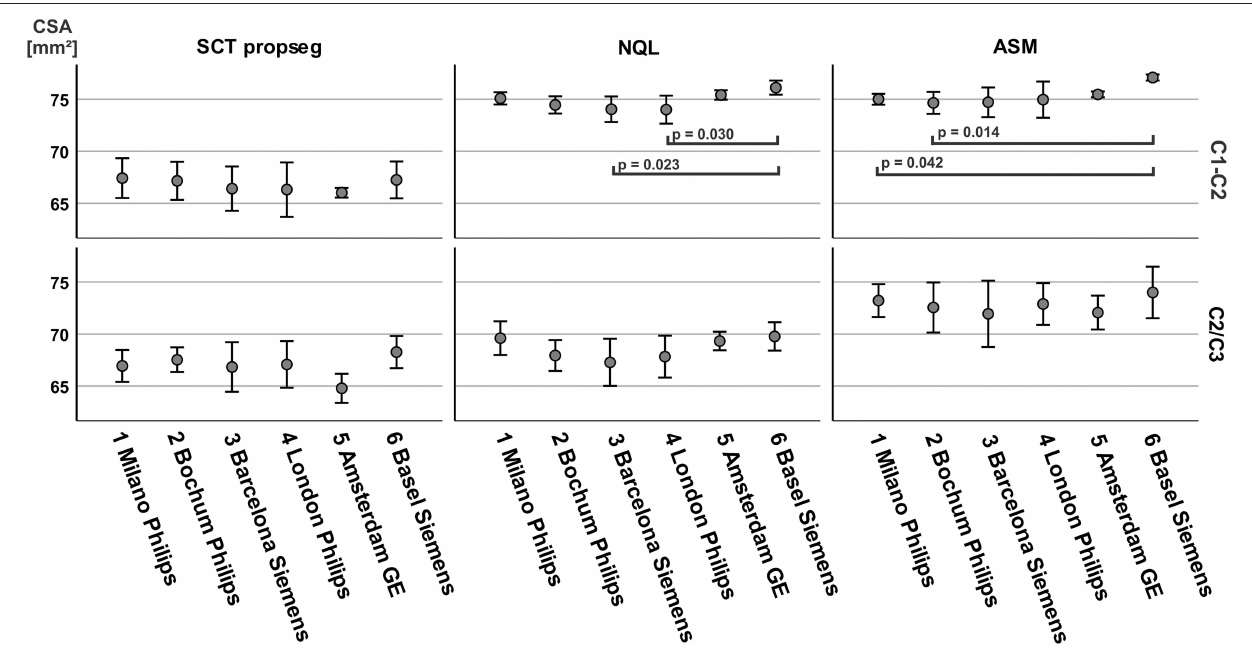
FIGURE 6 | Between-center comparison of cross-sectional area (CSA), differentiated for post-processing software and cord level. CSA was aggregated across brain and cord MRI ( N 6, for each center). Significance between groups by Kruskal–Wallis test with post-hoc comparisons between pairs of sites adjusted for multiple = comparisons with Dunn’s post-hoc test and Bonferroni